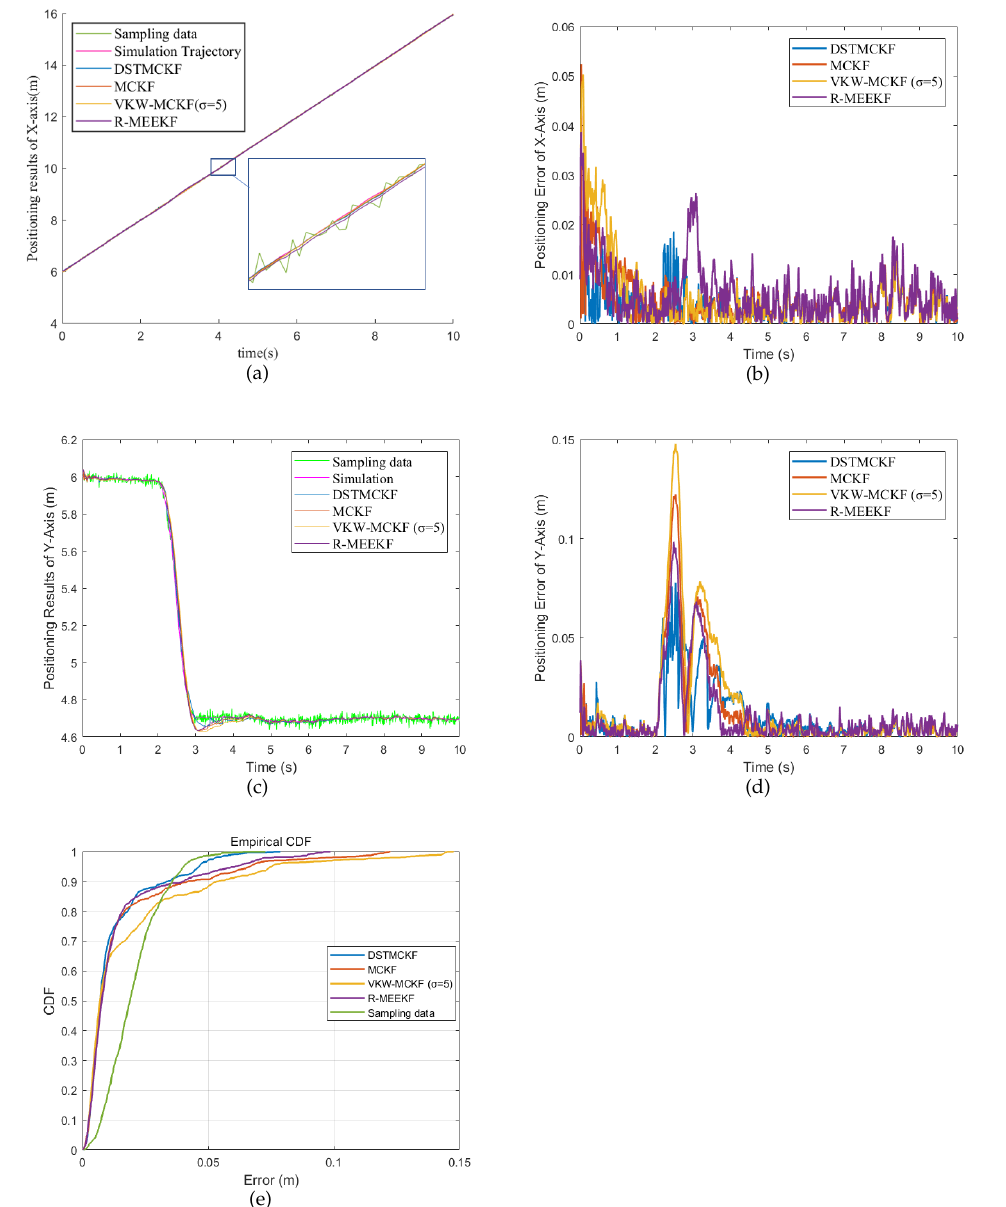
Figure 6. Simulation Results in Case (1). ( a ) Positioning result of X-label when σ = 1.2; ( b ) error of X-label when σ = 1.2; ( c ) positioning result of Y-label when σ = 1.2; ( d ) error of Y-label when σ = 1.2; ( e ) CDF of each filter when σ =